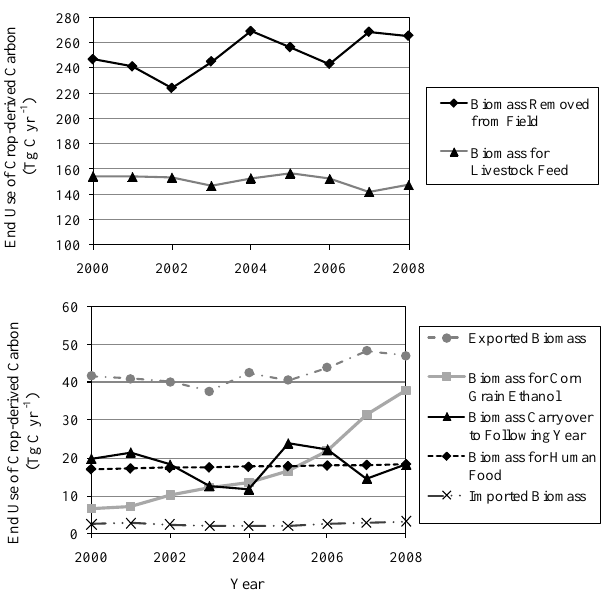
Fig. 2. Components of the US crop carbon budget from 2000 to 2008. Some components of the US crop carbon budget are shown here to illustrate where predominant changes in the budget occurred between 2000 and 2008. See Table 3 for all